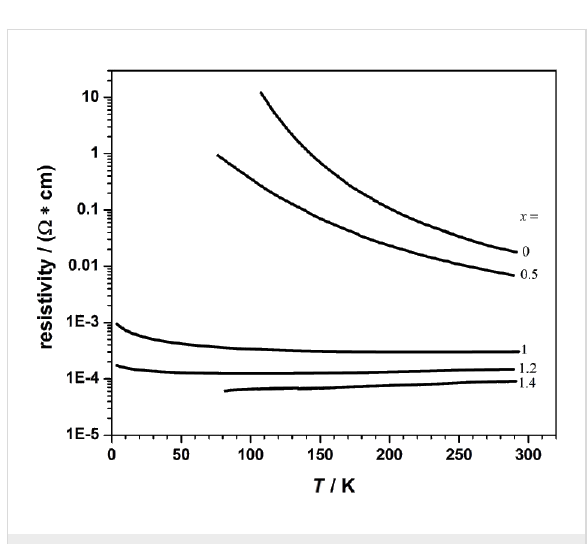
Figure 7: XRD θ –2 θ scan of 13 nm thick La 1 Sr 1 NiO 4 on LSAT(100) (S). Laue fringes can be seen in the left inset, magnification around the (006) diffraction peak. In the right inset, the c-axis value, obtained by applying the Bragg equation for each peak position and subsequent refinement with the Nelson–Riley function, for thin films of La 2 − x Sr x NiO 4 epitaxially grown on LSAT(100) substrate.